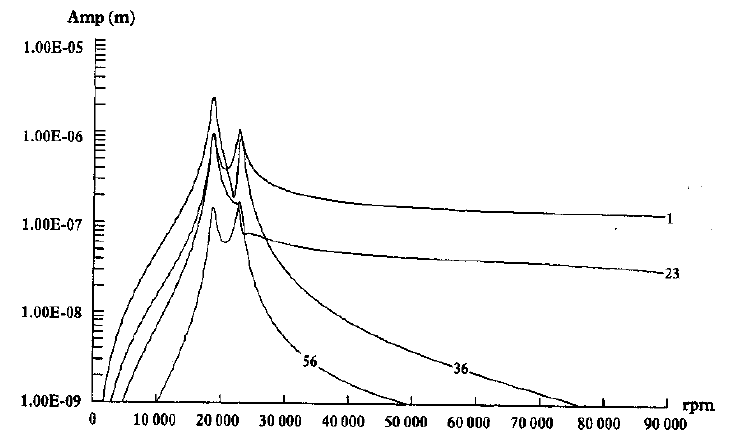
Fig. 12. Mass unbalance response (mass on rotor 1).